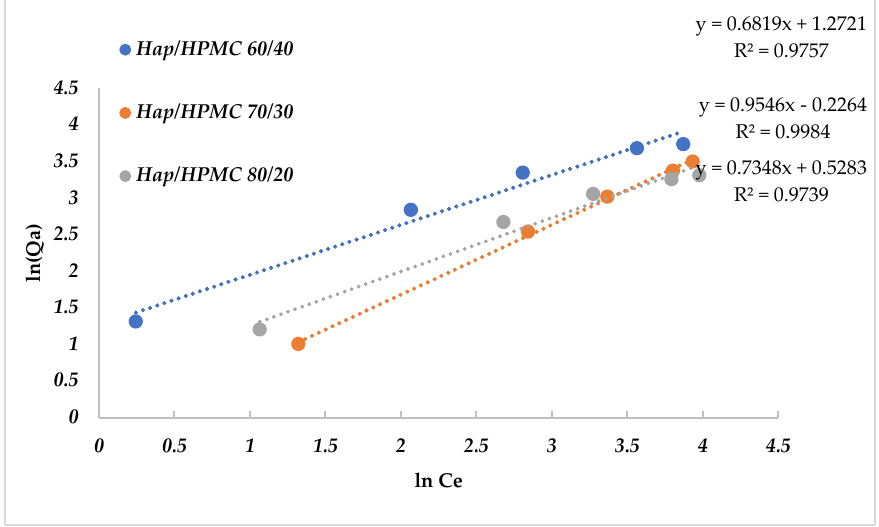
Figure 16. Linearization of the Freundlich equation for adsorbent/adsorbate systems. C e : concentra- tion of adsorbate, Q a : adsorbed quantity.